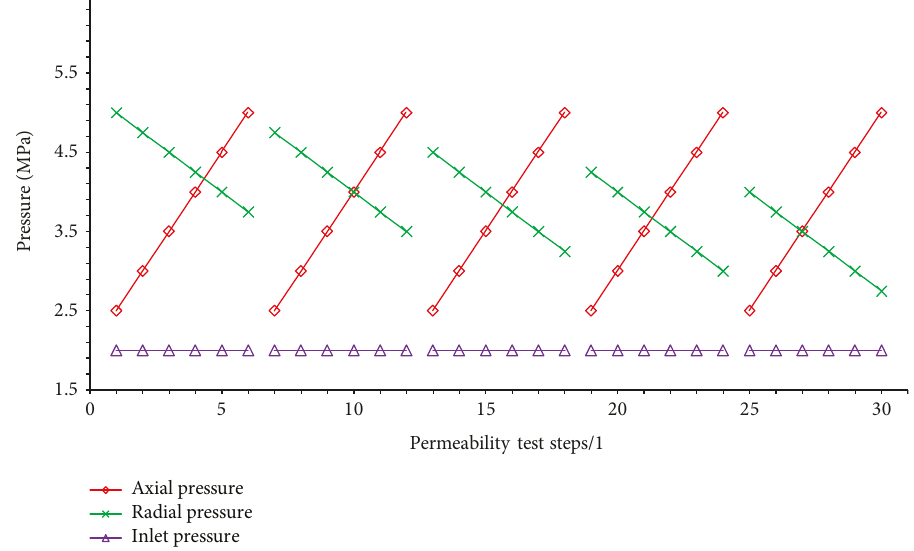
Figure 7: Tests on the pore pressure e ff ect on the permeability under constant average e ff ective normal stress.